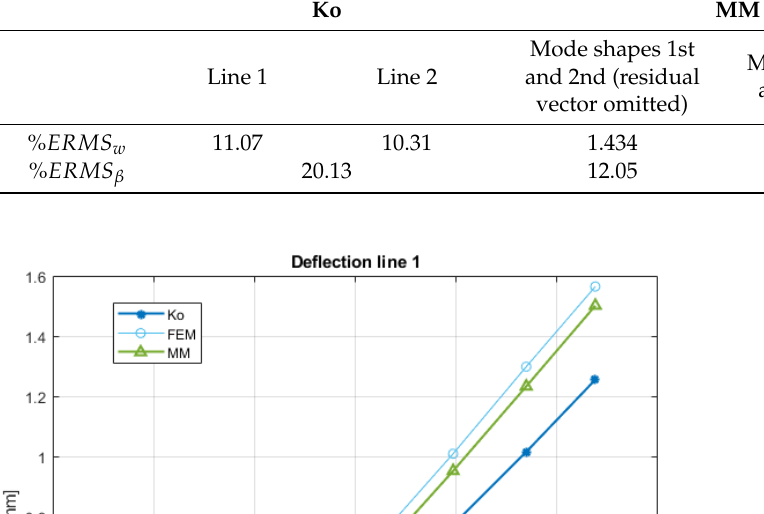
Table 5. Overall errors for Ko’s Displacement Theory and Modal Method.